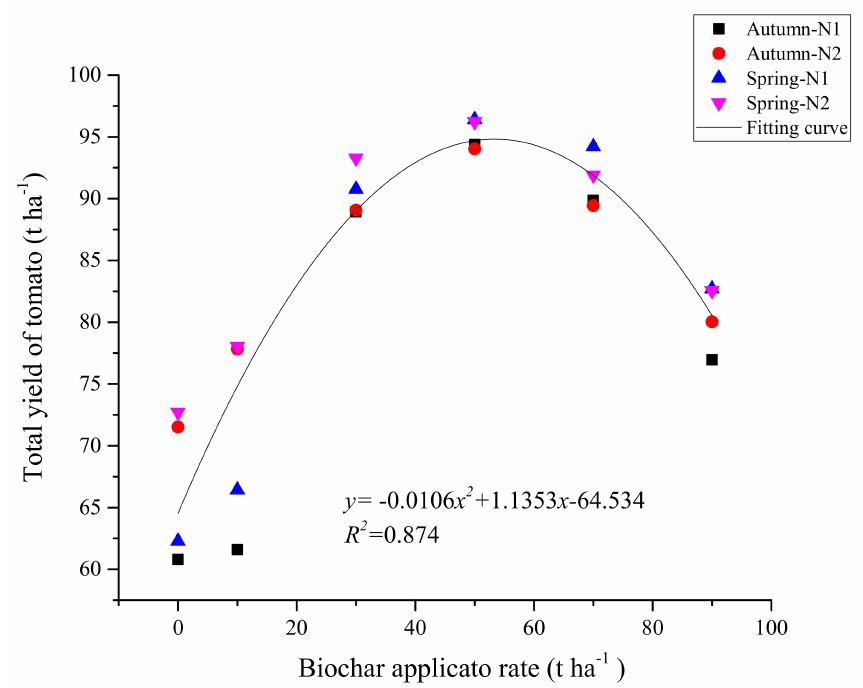
Figure 6. The total yield of tomatoes varied with the amount of biochar (C0, C10, C30, C50, C70, or C90) and the N fertiliser treatments (N1 and N2) in the spring and autumn.